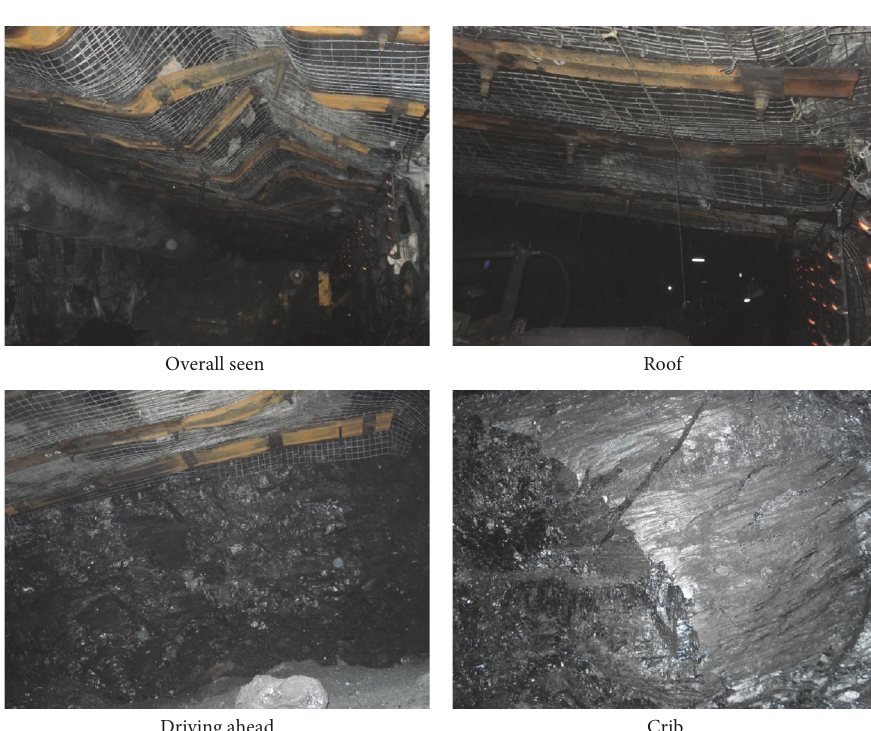
Figure 4: The photos of selected